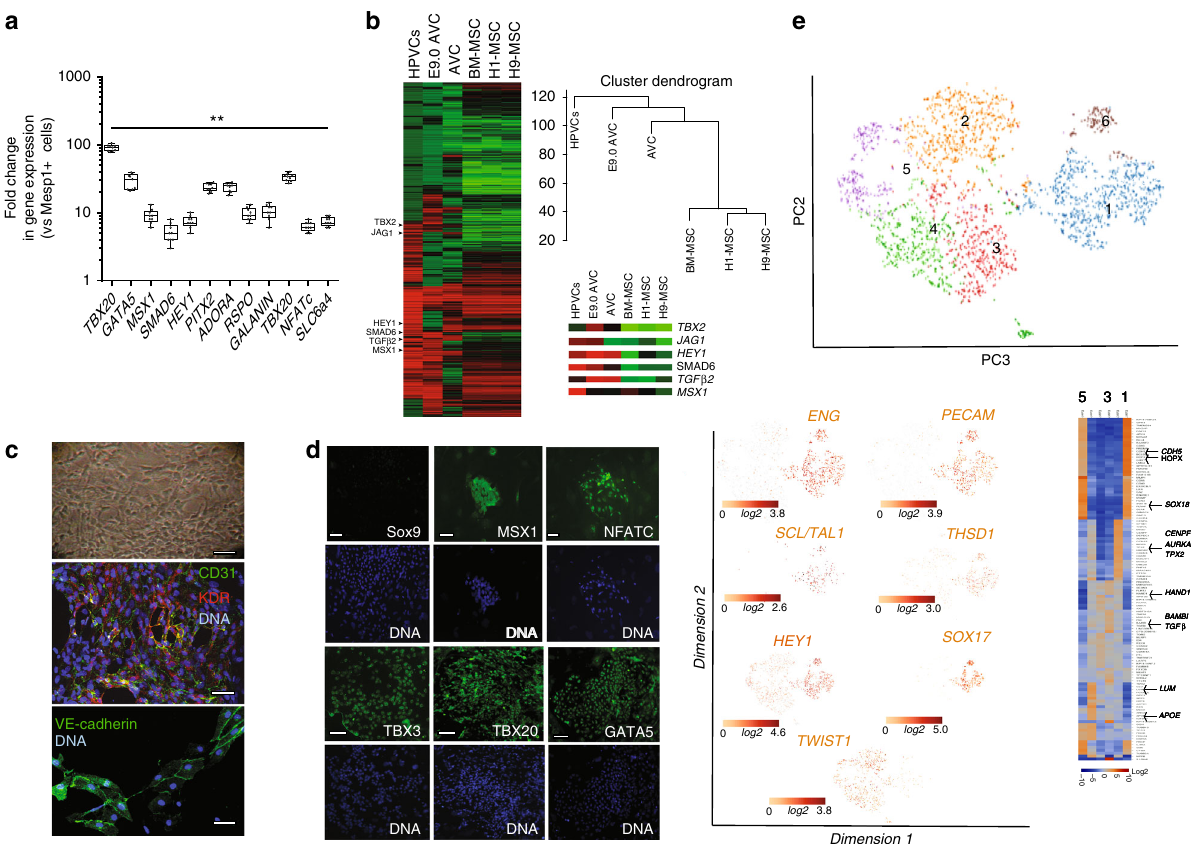
Fig. 1 Gene and protein expression pro fi les of human valve progenitors. SSEA-1 + -sorted human MESP1 + cells were treated with 10 ng/ml FGF8, 2 ng/ml FGF2 and 30 ng/ml VEGF for 6 days. a RNA was then collected and cDNAs of FGF8/VEGF-treated cells (HPVCs) were run in Real-Time PCR (mean ± SEM of 9 separate cell differentiation experiments). Data are normalized to 1 as the level of gene expression in SSEA1 + MESP1 + cells. (**signi fi cantly different from 1; p ≤ 0.01). Boxes and whiskers (min to max) show the values lower than the 2.5th percentile and greater than the 97.5th percentile as circles. b cRNAs ( n = 3 separate cell differentiation experiments) were used for microarrays and normalized vs. MESP1 + cells from the same respective cell sorting. Heatmaps of transcriptomes of HPVCs, E9AVC (our data), AVC GDS3663 and MSCs (GDS1288). A few AVC-speci fi c genes are highlighted in the inset. c Bright fi eld image (top) and co-immunostaining of VEGF/FGF8/FGF2-treated SSEA-1 + /MESP1 + derived colonies with anti-CD31 and anti-Flk1 (KDR) or anti-VE-cadherin antibodies. Data are representative of 5 separate cell differentiation experiments. d Immunostaining of VEGF/FGF8-treated SSEA-1 + /MESP1 + derived colonies with anti-Sox9, -Msx1, -Nfatc1,-Tbx3, -Tbx20 and -GATA5 antibodies (green) and DAPI (blue). The data are representative of 5 experiments. The scale bar indicates 50 μ m. e HPVCs were further sorted using anti-CD31 conjugated beads and used in single-cell RNA sequencing. t-distributed stochastic neighbor embedding (t-SNE) 2D cell map 10X genomics ( n = 2440 cells) (upper panel). Highlight of cell populations expressing genes marking endothelial, hemogenic and early EMT cells (lower panel) and heatmap of graph-based Log2 fold changes in gene expression of cell cluster compared to all other cells (lower right panel). Source data are provided as a Source Data